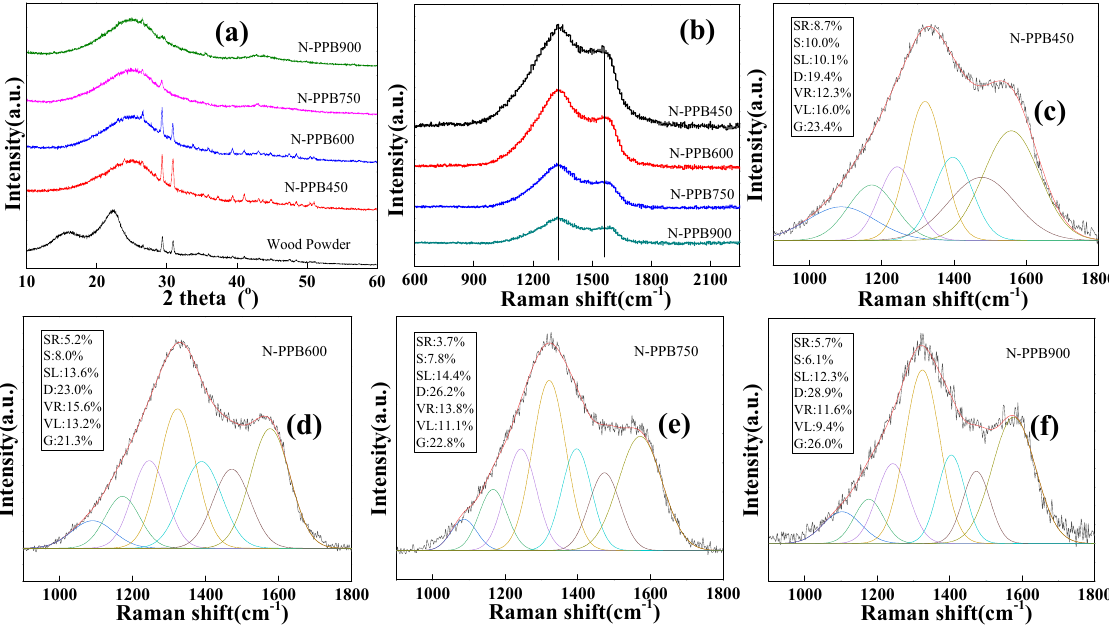
Figure 2. ( a ) XRD patterns, ( b ) Raman spectra, and ( c − f ) deconvoluted Raman spectra of N-PPB450, N-PPB600, N-PPB750, N-PPB900.